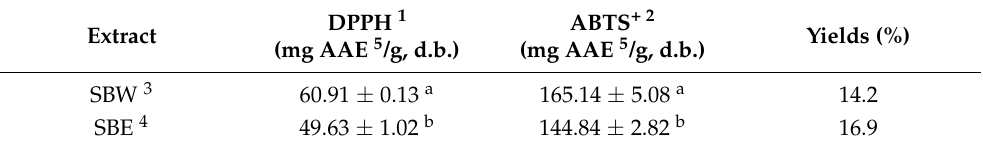
Table 1. Antioxidant activity based on DPPH and ABTS + assays of S. borealis extracts. DPPH 1 ABTS + 2 Extract Yields (%) (mg AAE 5 /g, d.b.) (mg AAE 5 /g, d.b.) SBW 3 60.91 ± 0.13 a